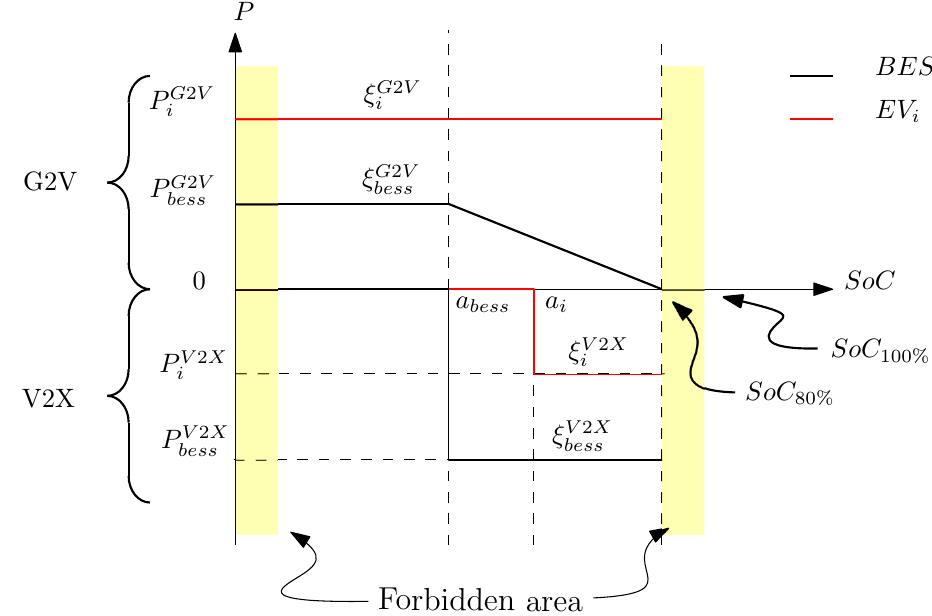
Figure 3. BESS and EV power level and priority as a function of SoC